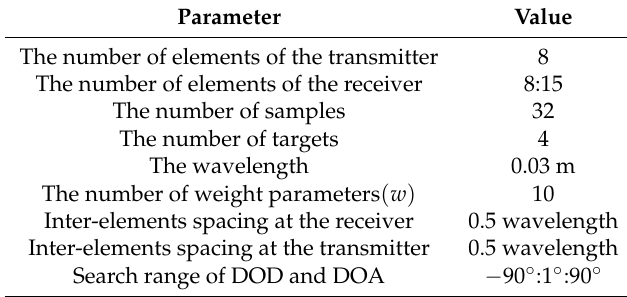
Table 4. Simulation parameters for the operation time